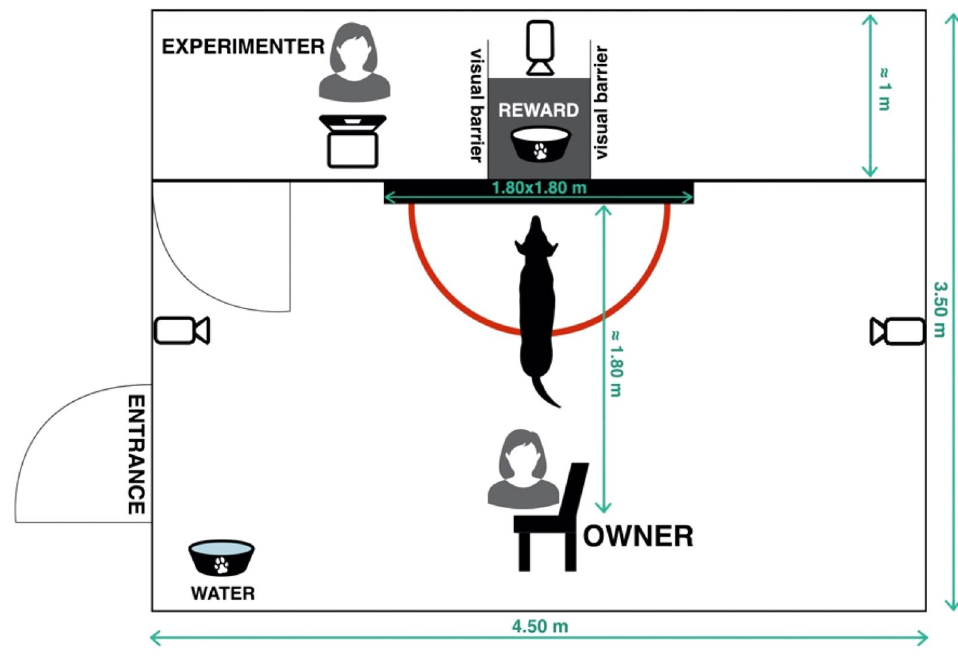
Figure 2. Set up of the room used for the